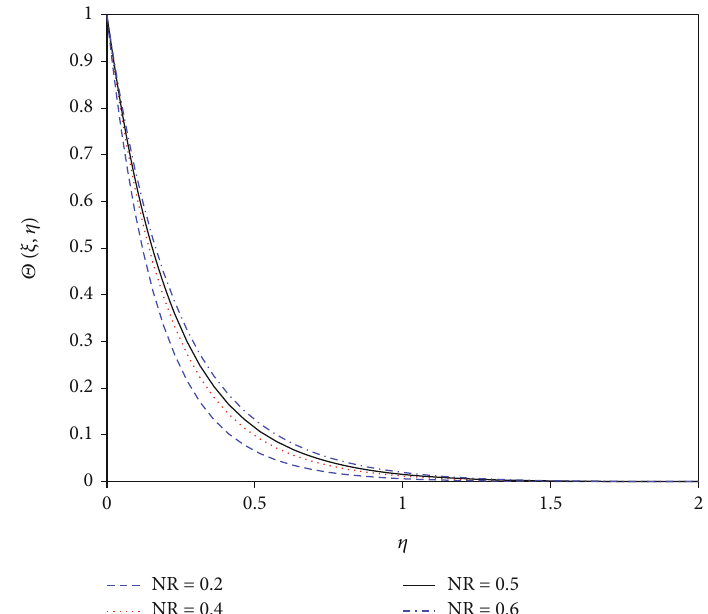
, when K = 0 : 5, ξ = 5, Pr = 10, n = 0 : 5, S = 1, Ω = 0 : 1, R